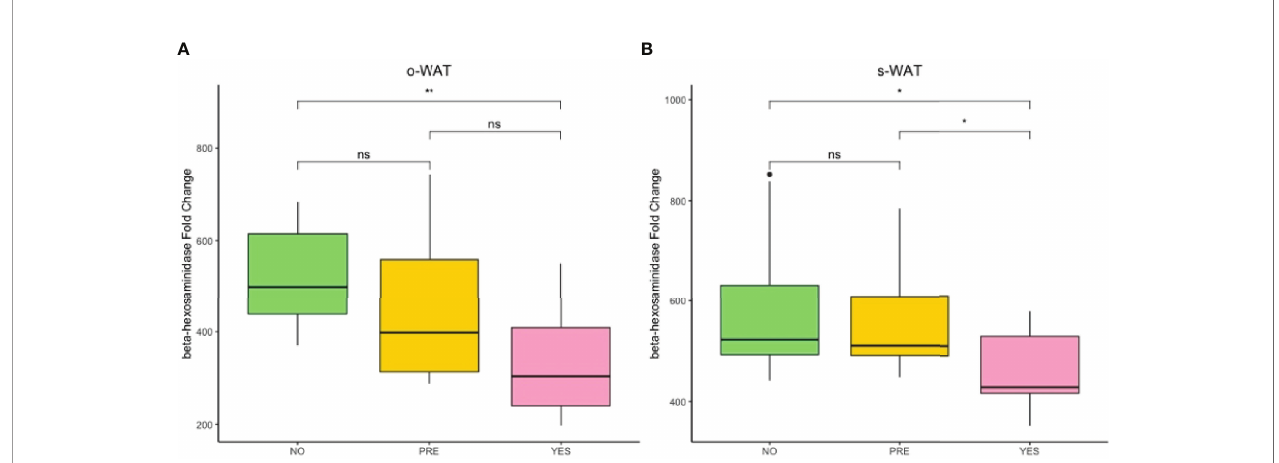
FIGURE 7 | Fold change variation of the expression of b -hexosaminidase. (A) Comparison of the fold change variation of b -hexosaminidase in o-WAT between the three groups. (B) Comparison of the fold change variation of b -hexosaminidase in s-WAT between the three groups. NO (non-type 2 diabetes group), PRE (pre type 2 diabetes group), YES (type 2 diabetes group), T2D (type 2 diabetes), s-WAT (subcutaneous white adipose tissue), o-WAT (omental white adipose tissue), n=60. “ ns ” means not signi fi cant, * (0.05 > p value > 0.01), ** (0.01 > p value >